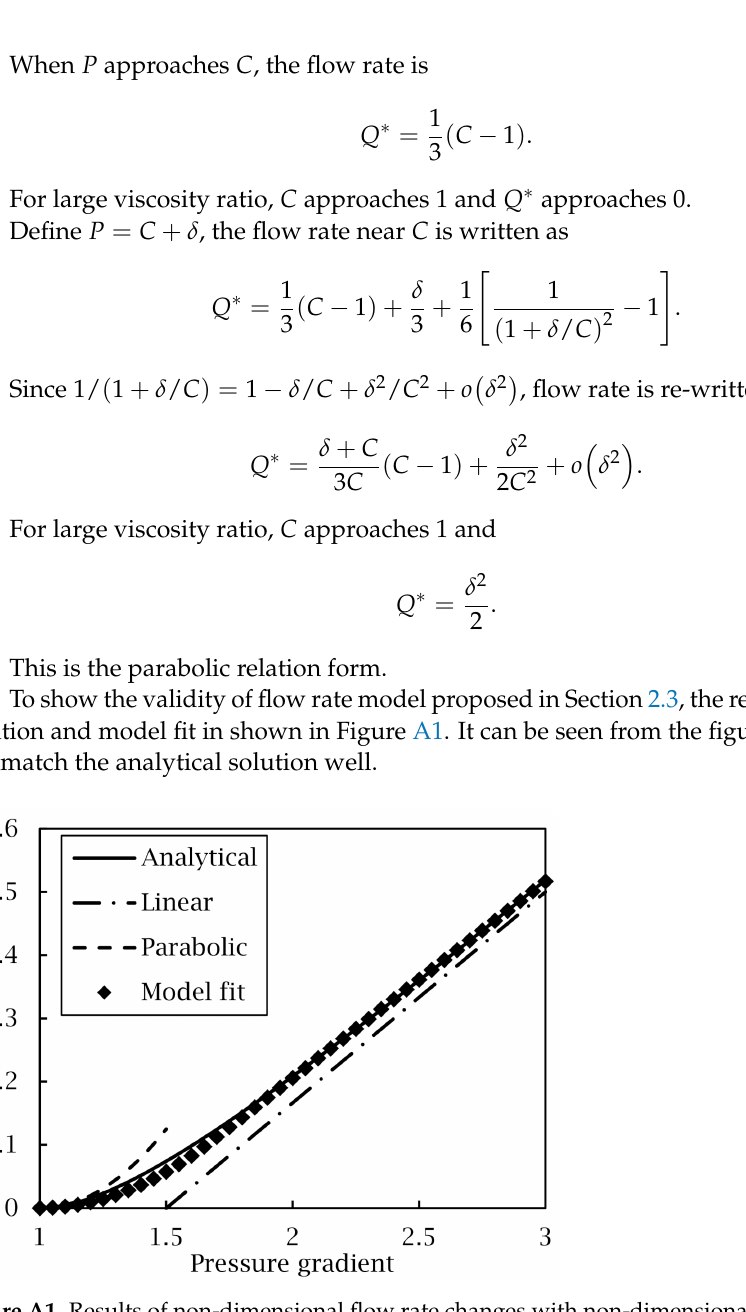
Figure A1. Results of non-dimensional flow rate changes with non-dimensional pressure gradient for Bingham flow through 2D parallel plate. The flow rate changes parabolically when pressure gradient is small and linearly when pressure gradient is large. The model that links parabolic and linear form can well match the analytical solution